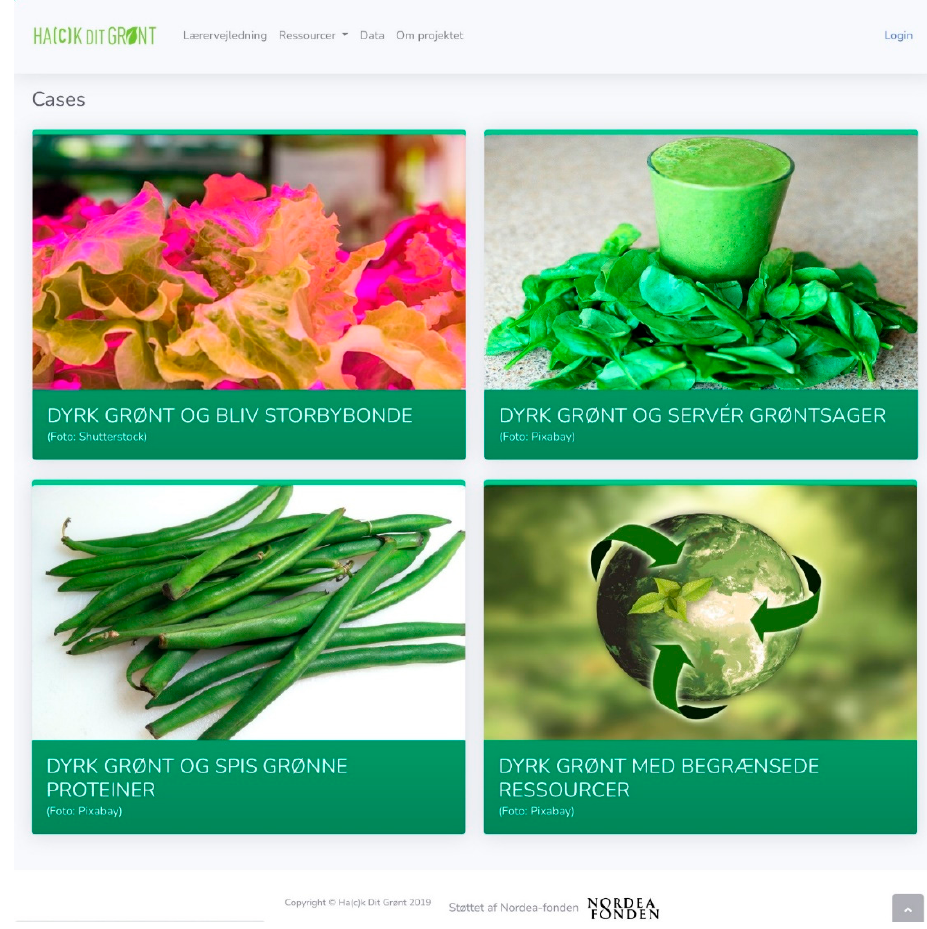
Figure 11. On the web-page (in Danish), users can easily select a case of interest. Clockwise from upper left corner, the cases are translated to “Grow green and become an urban farmer”, “Grow green and serve vegetables”, “Grow green with limited resources”, and “Grow green and eat green proteins”. Under each case, there are 15–20 educational tasks related to the theme of that case.